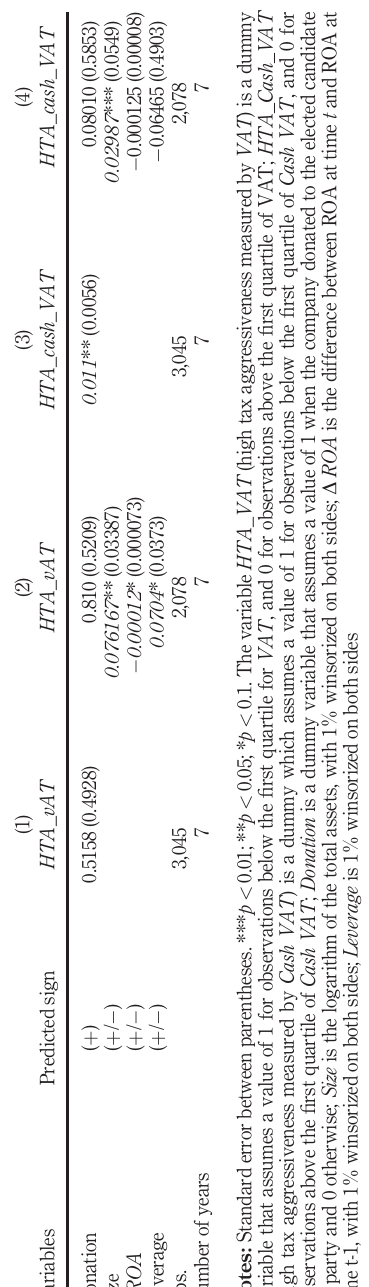
Table VI. Logistic regressions for high tax aggressiveness